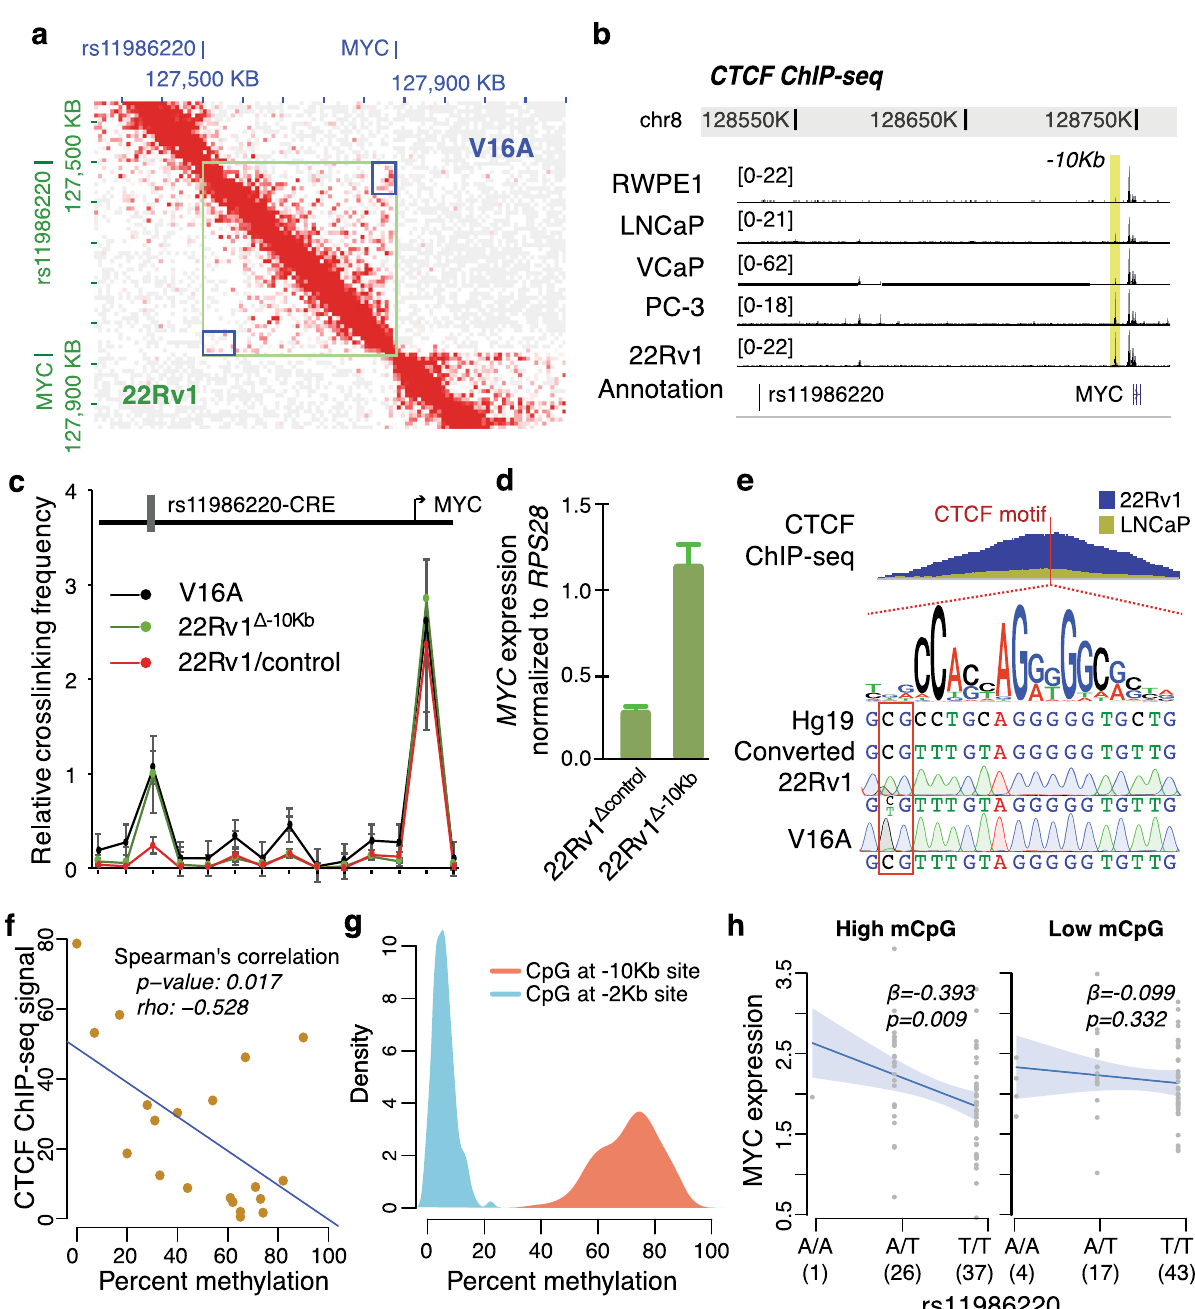
Fig. 4 Methylation-dependent variable CTCF binding at – 10 Kb locus regulates MYC eQTL. a Hi-C interaction map in 8q24.21 region in V16A (top-right triangle) and 22Rv1 cells (bottom-left triangle). The green square denotes the rs11986220-containing rCRE and MYC -promoter boundary and the blue square indicates the interaction points between these loci. b CTCF ChIP-seq signals in PCa cell lines between the rs1198220-containing rCRE and MYC promoter. The yellow bar denotes the CTCF binding site 10 Kb upstream of MYC promoter ( – 10 Kb site) which accumulates almost fourfold more CTCF deposition in 22Rv1 cells compared to LNCaP cells. c Interaction across chromatin regions between the rCRE and MYC promoter as determined by 3C assay. The data are shown in mean ± s.d. ( n = 3). d Quanti fi cation of MYC transcripts by qPCR in 22Rv1 cells upon CRISPR/Cas9-mediated deletion of the – 10 Kb CTCF site. Error bars denote standard error of mean ( n = 2). e The top track indicates CTCF ChIP-seq pro fi le in two cell lines and the position of CTCF binding motif (red bar). The motif logo is shown on the second track. The sequences shown are of the reference genome and bisul fi te converted genome. The bottom two tracks show Sanger ’ s sequencing data upon bisul fi te conversion in V16A and 22Rv1 cells. The red box denotes the differentially methylated CpG dinucleotide. f Correlation between the methylation level of this CpG and CTCF ChIP-seq signal at this locus in ENCODE cells. Each circle denotes a cell line and the blue line indicates the regression coef fi cient. See also Supplementary Fig. 4. g Distribution of methylation level of CpGs in – 10 Kb and – 2 Kb sites in 128 prostate tissues as determined by the whole-genome bisul fi te sequencing. h Association between rs11986220 genotype and MYC expression in prostate tissues dichotomized by high (left panel) and low (right panel) level of methylation of the CpG in – 10 Kb CTCF binding motif. The lines indicate the best fi t for the regression models and the shaded areas indicate 95% con fi dence interval. The regression coef fi cient, β , and the p value are calculated using linear regression analysis. Source data are provided as a Source Data fi